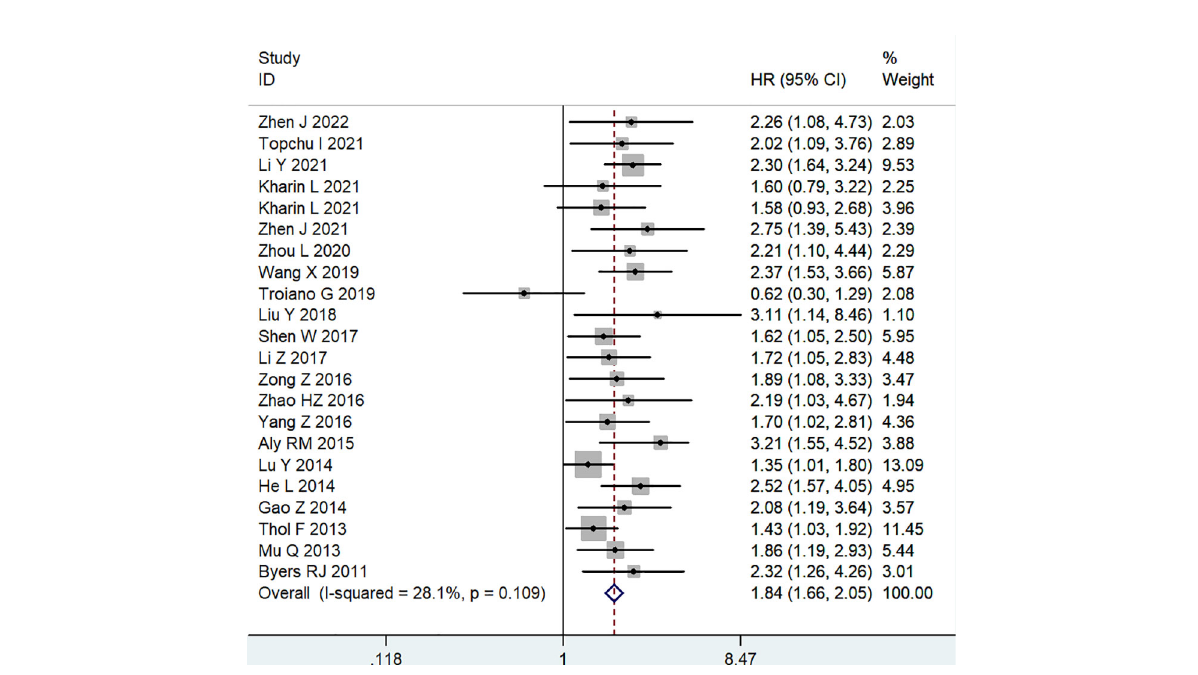
FIGURE 2 Forest plot of studies evaluating hazard ratios of high MSI2 expression and the overall survival of cancer